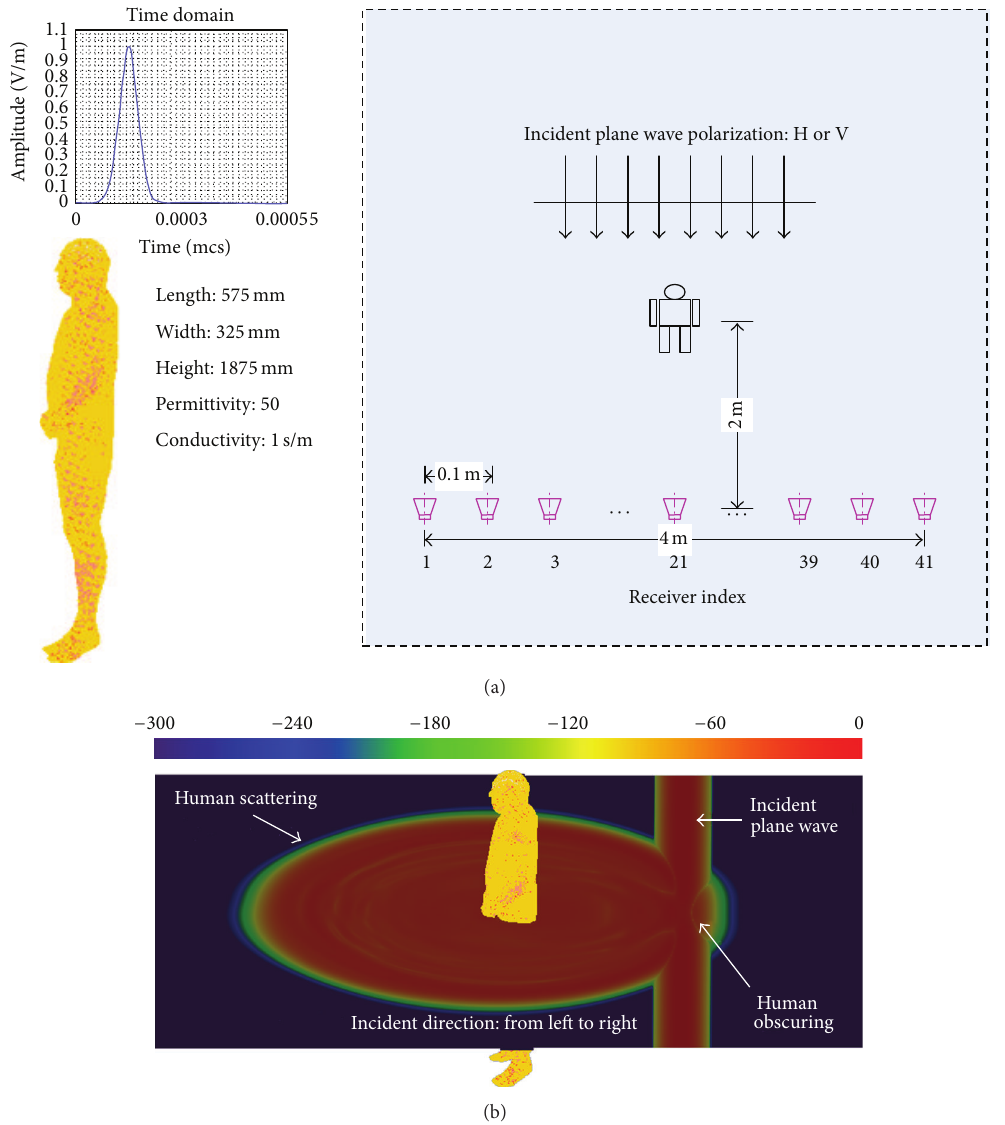
Figure 5: Simulation model and field snapshot in FDTD calculation. (a) Left-top: Gauss impulse signal is used for exciting the wave; left- down: description about human model; right: simulation model in calculation. (b) Human obscuring effect in the field